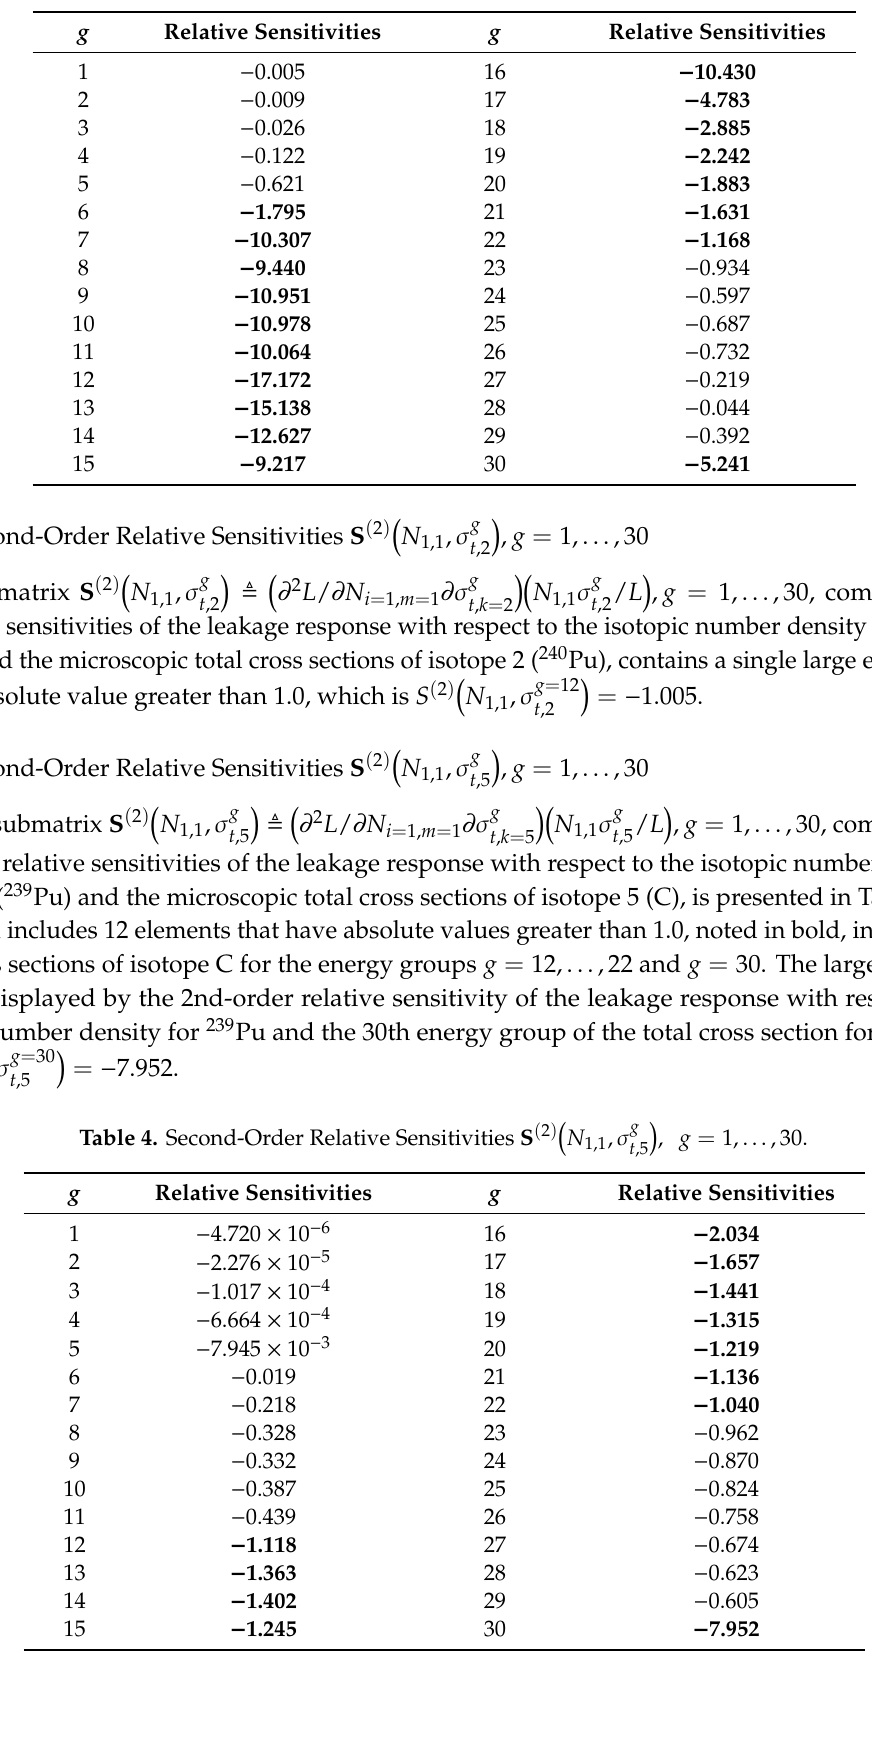
Table 3. Second-Order Relative Sensitivities S ( 2 )